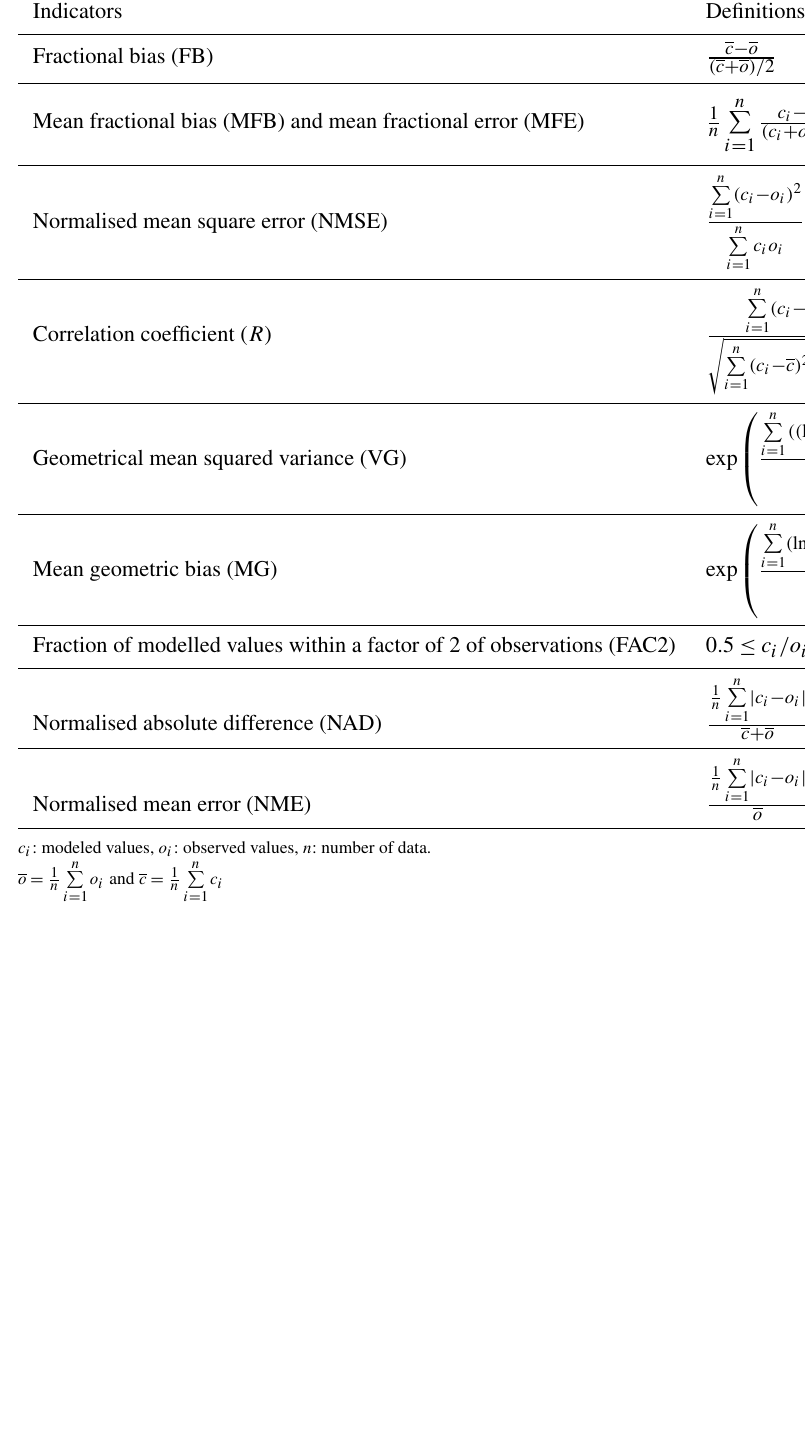
Table A1. Definitions of the statistical indicators. Indicators